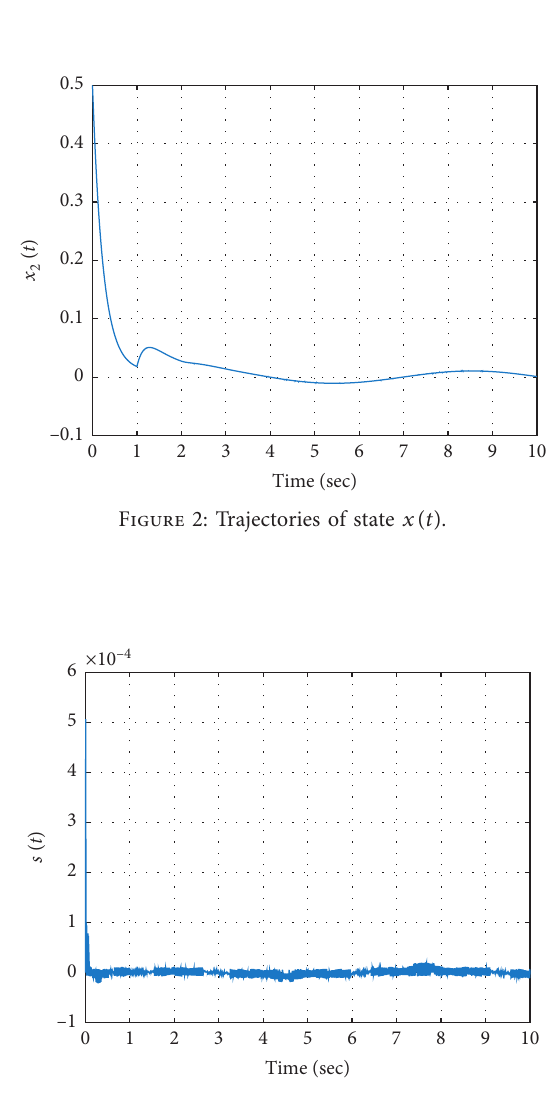
Figure 3: Switching surface function s ( t ) .